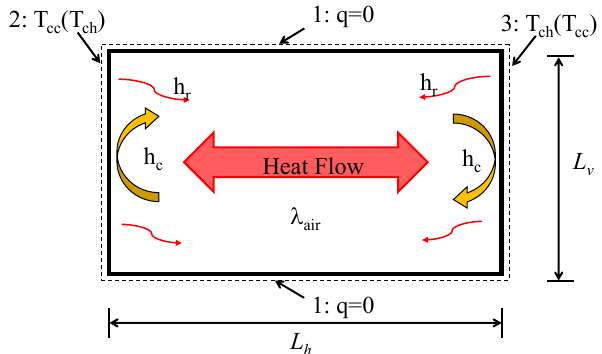
Figure 2. Schematic diagram of cavity heat transfer model.